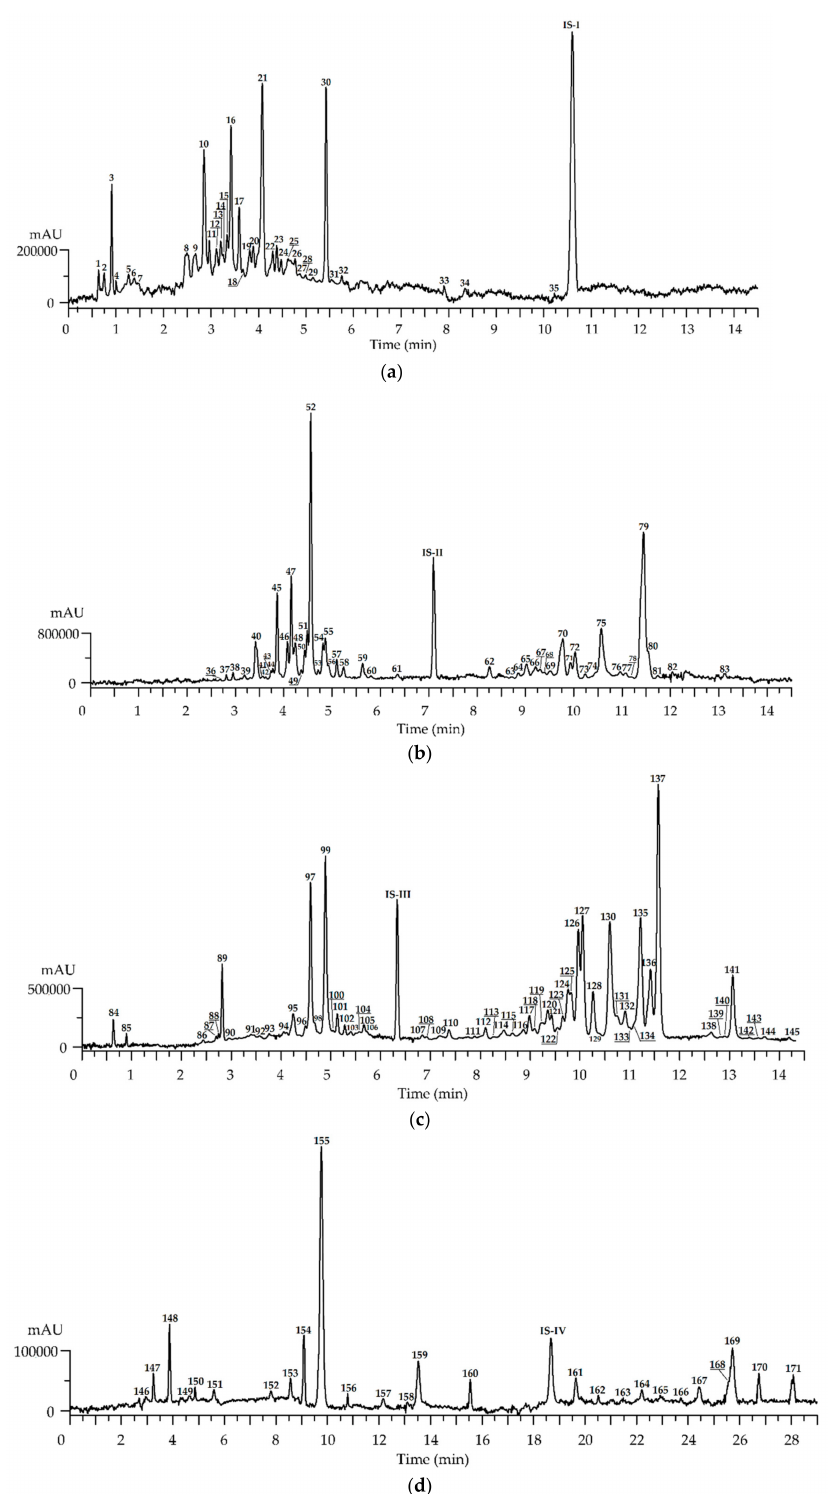
Figure 4. High-Performance Liquid Chromatography with Electrospray Ionization Triple Quadrupole Mass Spectrometric Detection (HPLC-ESI-tQ-MS) chromatogram (Total Ion Chromatogram (TIC) mode, negative ionization) of solid-phase extraction (SPE) eluates of R. adamsii leaves (July sam- ple) extract: H 2 O eluate (SPE-1; a ), MeOH eluate (SPE-2; b ), NH 3 -MeOH eluate (SPE-3; c ), DMSO eluate (SPE-4; d ). Compounds are numbered as listed in Table 2. Internal standards used: 20- hydroxyecdysone (IS-I), apigenin-7- O -glucoside (IS-II), apigenin-7- O -glucuronide (IS-III), epigallo- catechin O -gallate